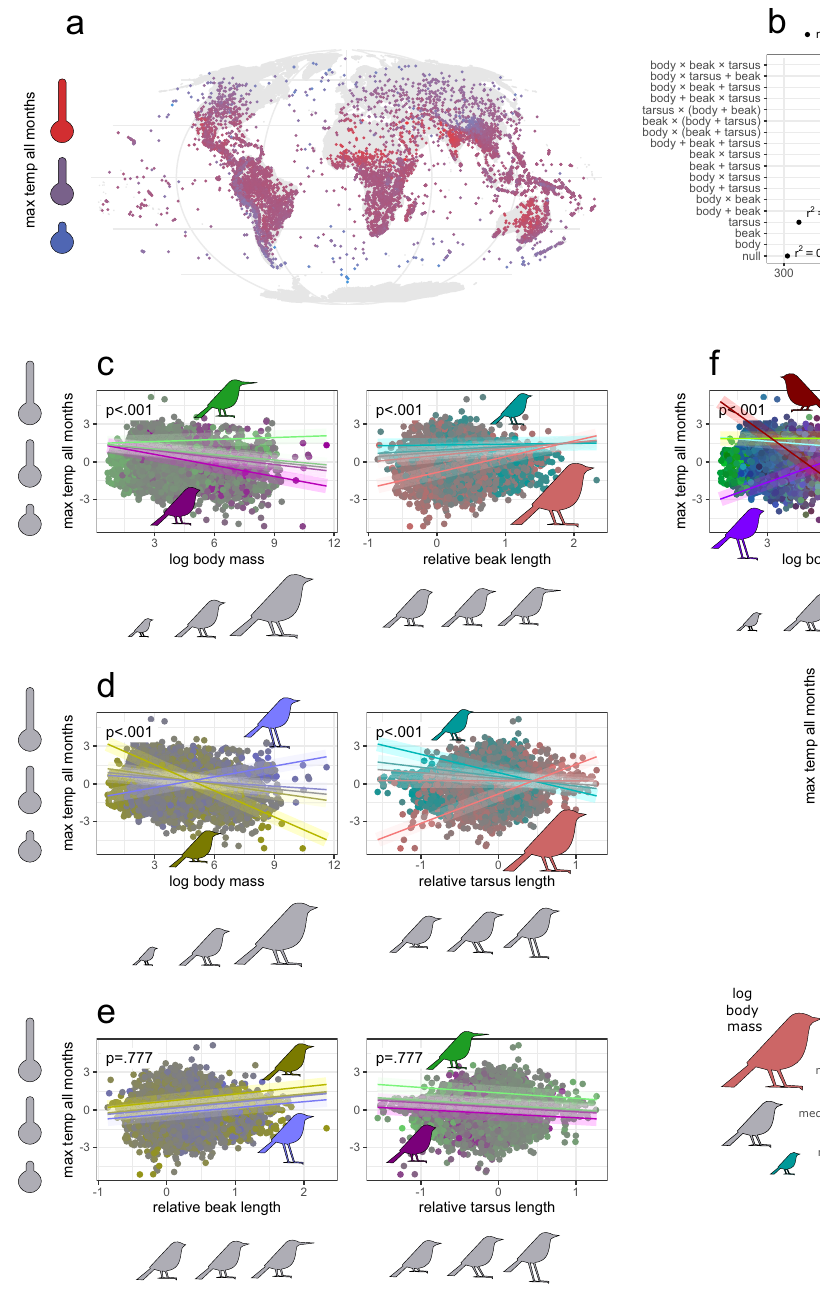
Fig. 4 | Global test for avian adaptation to maximum temperature across all months by shifts in body size (Bergmann ’ s rule) and appendage size (Allen ’ s rule) across 9962 (99.7%) avian species. Distribution of environmental tem- perature across species geographic ranges ( a ). Model selection procedure for predicting max temperature all months ( b ), involving models with different combinations of log body mass, relative beak and tarsus length as fi xed and interaction terms; AIC — Akaike Information Criterion, r 2 — coef fi cient of deter- mination. Exemplar models with two-way interaction of body size and relative beak length ( c ) or tarsus length ( d ) illustrate how Bergmann ’ s rule operate across steeping quantiles of relative appendage length (left plots) and how Allen ’ s rule operate across steeping quantiles of body size (right plots). An exemplar model with two-way interaction of relative beak length and tarsus